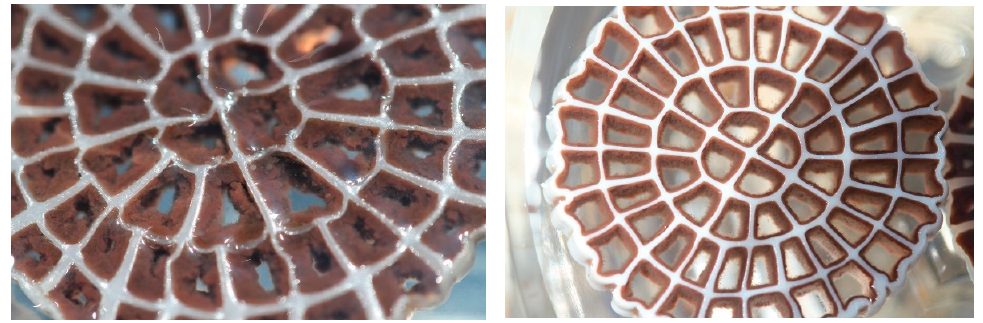
Figure 3. Photo of AnoxK TM 5 carriers 1 year after start-up ( left : “seed” carrier, right : “virgin” car- rier).